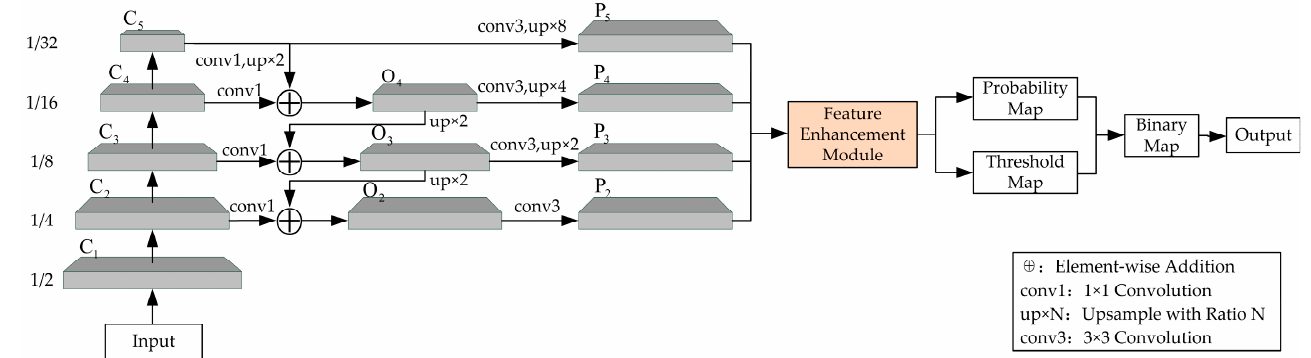
Figure 1. Framework of scene text detection based on multi-headed